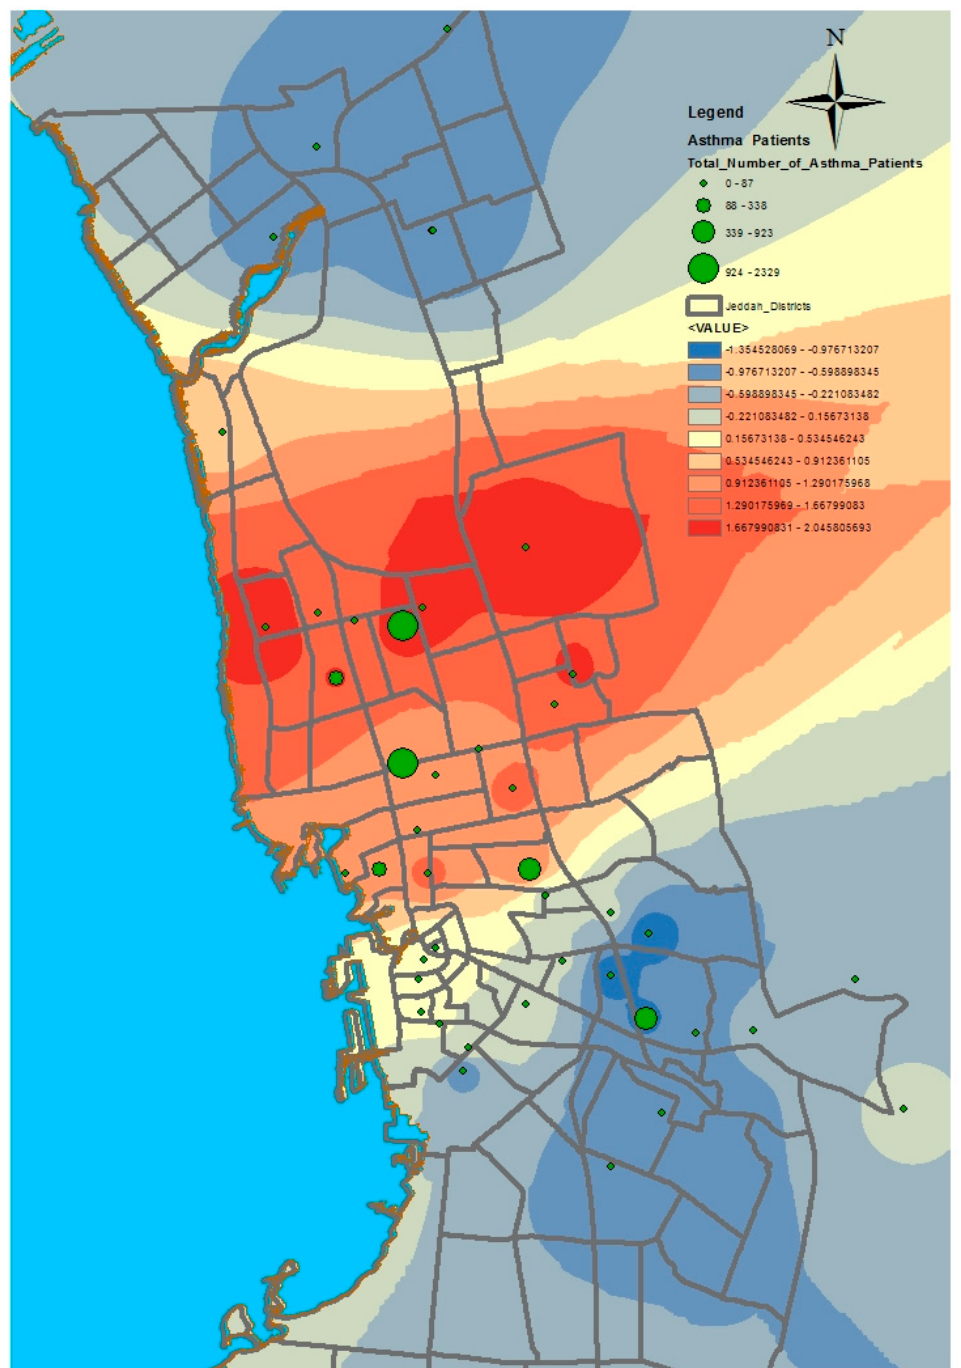
Figure 10. Hotspot analysis for asthma patients.